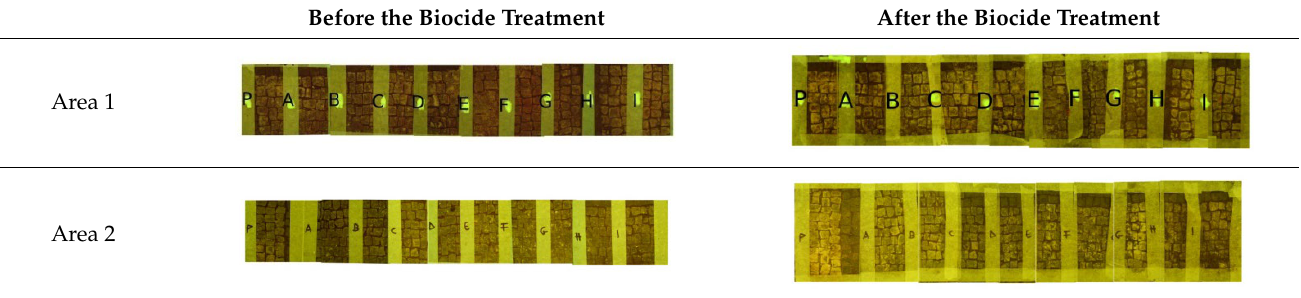
Table 4. Images of areas 1 and 2 before the treatment with EOs and after the cleaning procedure in UVL.